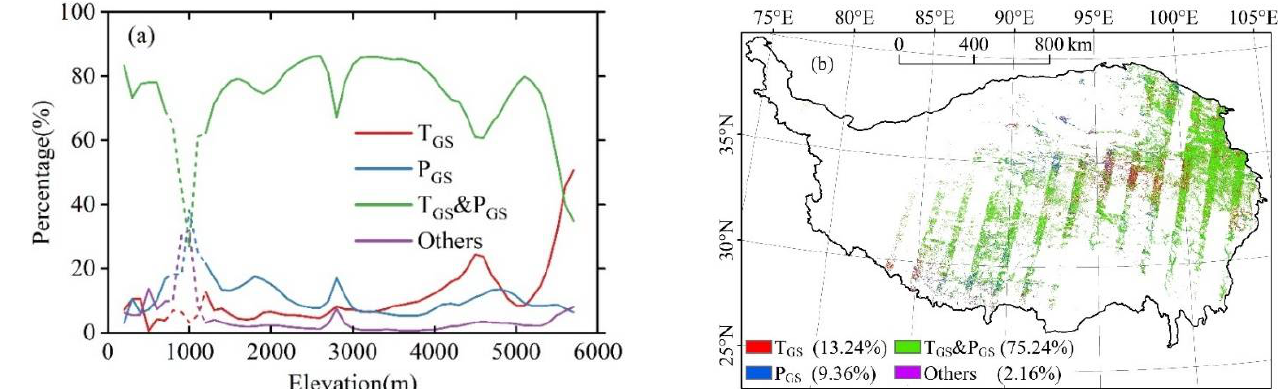
Figure 5. ( a ) The proportion of pixels belonging to four different cases of driving factors at each 100-m elevation bin: the red line indicates the proportion of pixels primarily affected by the growing season temperature (T GS ), the blue line indicates the proportion primarily affected by the growing season precipitation (P GS ), the green line indicates the proportion primarily affected by both T GS and P GS , and the purple line indicates the proportion primarily affected by other factors. The dotted line indicates where the number of pixels in the elevation bin was less than 1000. ( b ) The spatial distributions of the pixels belonging to the four different cases.